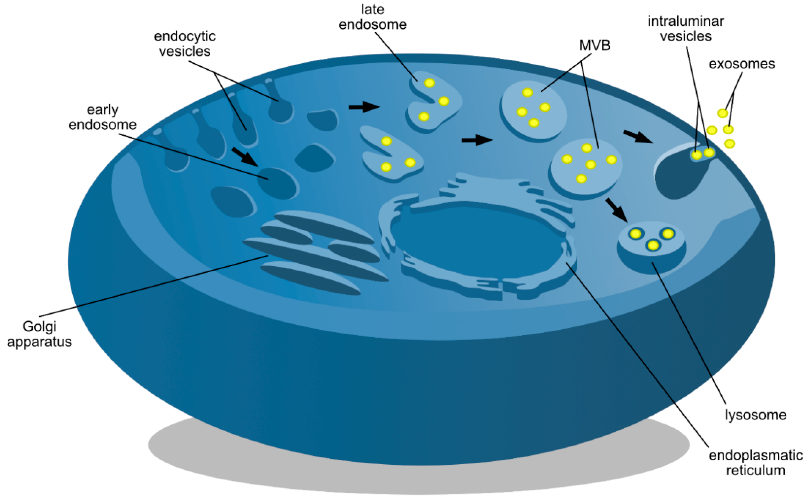
Figure 2. Endocytic pathways in the process of exosome biogenesis. Different steps of exosome biogenesis are demonstrated including early endosome formation, late endosome formation and multivesicular body (MVB) formation, respectively. MVB is then either transported into the lysosome for lysosomal exocytosis or fused with the endosomal membrane followed by exosomes release into the extracellular space. Two main organelles are shown including Golgi apparatus and endoplasmic reticulum due to their interaction with early endosomes as soon as they are formed from endocytic vesicles.